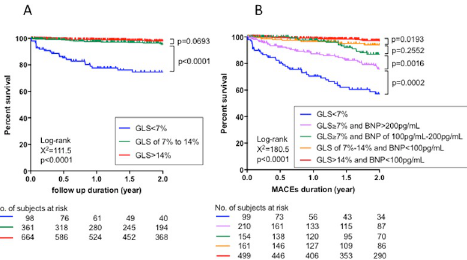
Fig 4. Kaplan − Meier survival analysis for cardiac death (CD; A) and major adverse cardiovascular events (MACEs; B) in the validation group. Each patient was classified into 1 of 3 groups, based upon GLS values from the CART analysis (Fig 4A), while each patient was classified into 1 of 5 groups according to cut-off values for BNP and GLS from the CART analysis (Fig 4B). Colored lines represent survival curves for CD (A) and MACEs (B). BNP; B- type natriuretic peptide, GLS; global longitudinal strain, CART; classification and regression